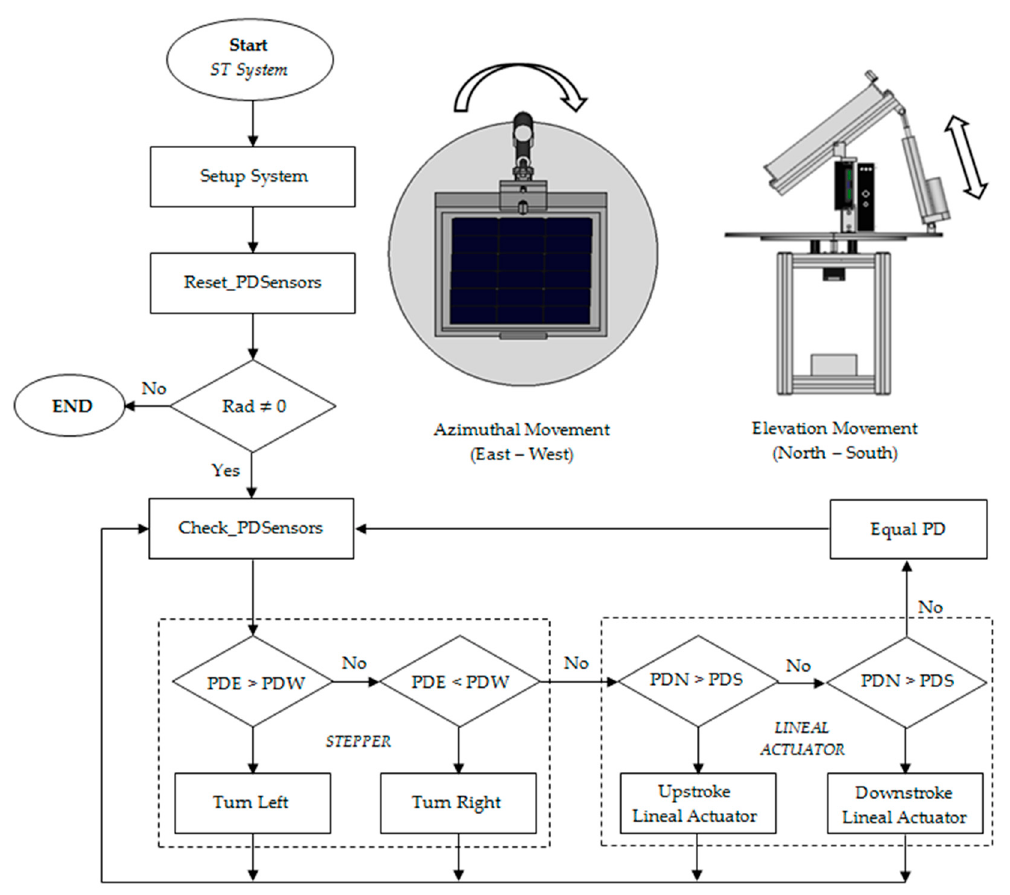
Figure 7. Flow diagram of prototype’s solar tracking.